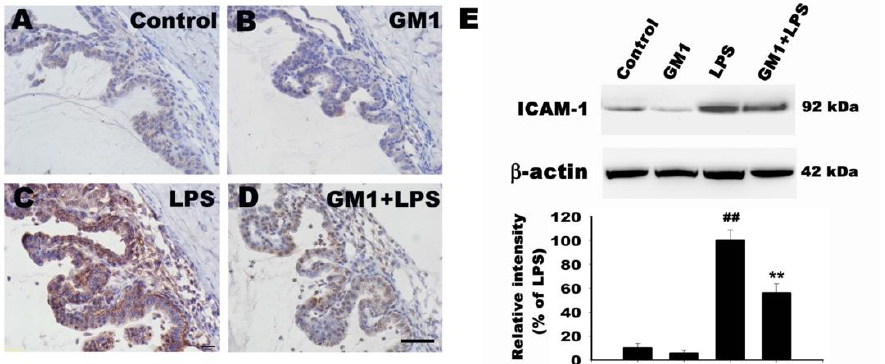
Figure 5. Effect of GM1 on ICAM-1 expression in the ICB of rats with EIU. Rats were pretreated with GM1 and then treated with or without LPS for another 24 h. Representative images of ICAM-1 immunohistochemical staining in sections from the four different treatment groups at 24 h after the LPS injection: vehicle control ( A ), GM1 alone ( B ), LPS ( C ) and GM1+LPS ( D ). ( E ) Western blot analysis of ICAM-1 levels. The protein bands from each treatment group were quantified by densitometry. GM1 significantly reduced LPS-induced increases in ICAM-1 expression. Data are presented as percentages of the LPS-treated group (mean ± S.D., n = 3). ## p < 0.01 compared with the control group; ** p < 0.01 compared with the LPS-treated group. Bar = 50 µ m. ICB: iris-ciliary